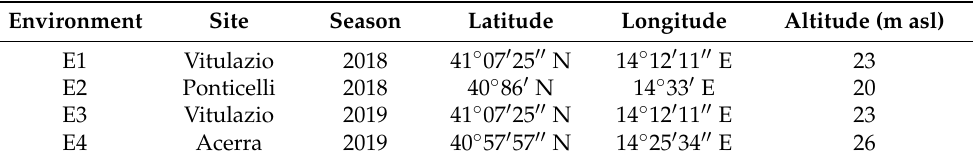
Table 2. Description of the environments. Latitude, longitude, elevation, and soil characteristics at the experimental sites.